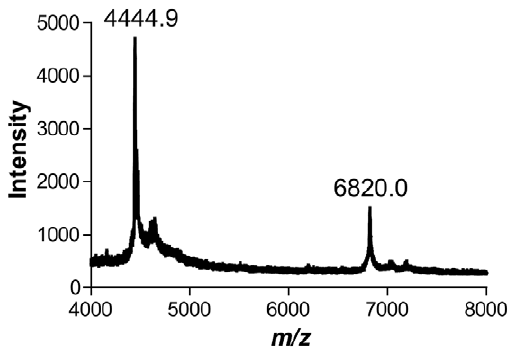
Figure 4. MALDI-TOF mass spectrometry analysis of crystals obtained from frog DGCR8 HBD. Ions with a ‘‘ + 1’’ charge state are labeled with their corresponding m/z values. The ion with m/z of 6820.0 roughly corresponds to the dimerization domain observed in the crystal structure.